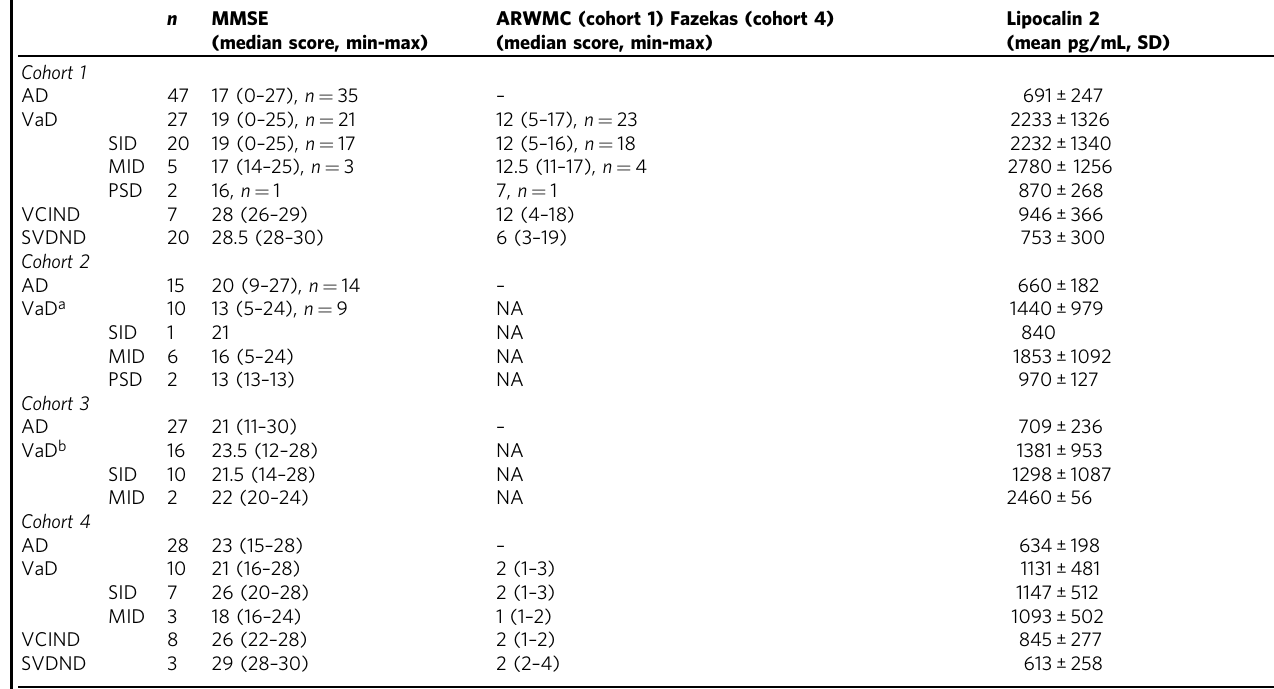
Table 2 Cognitive scores, white matter hyperintensities, and CSF LCN2 levels.